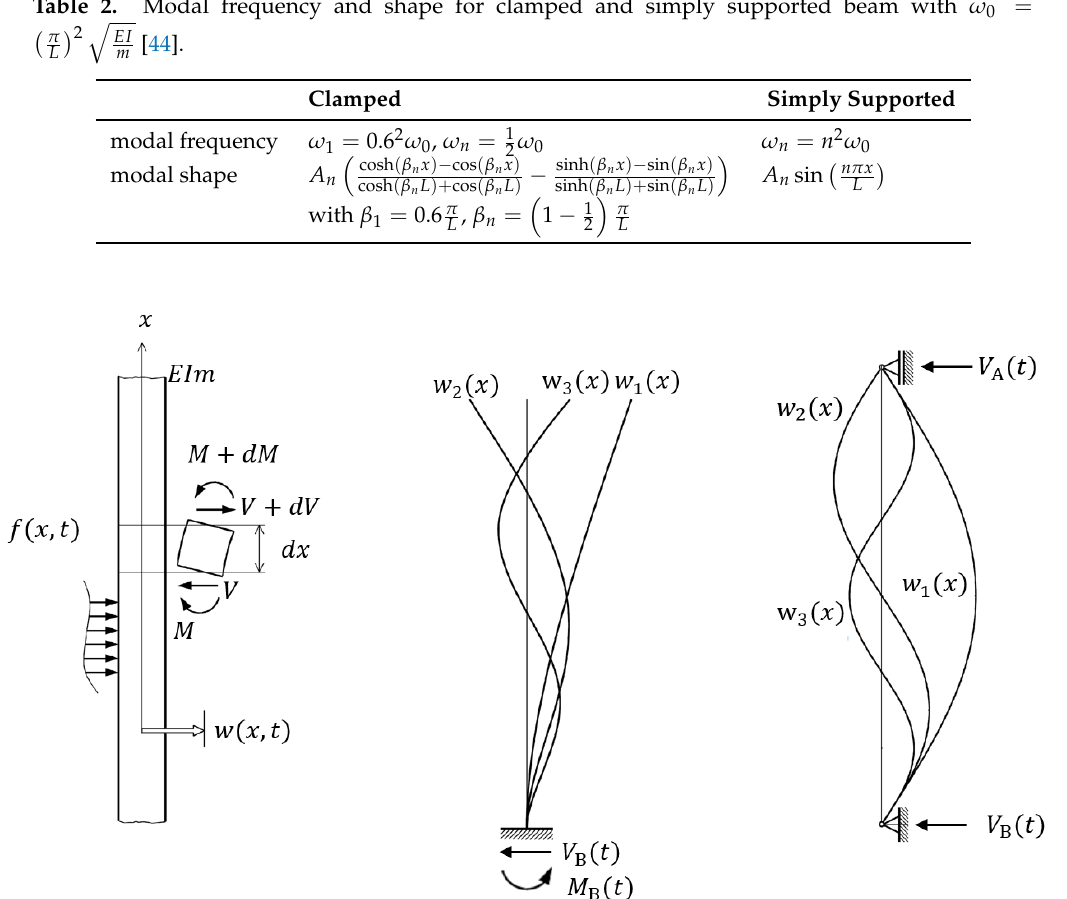
Modal frequency and shape for clamped and simply supported beam with ω 0 =